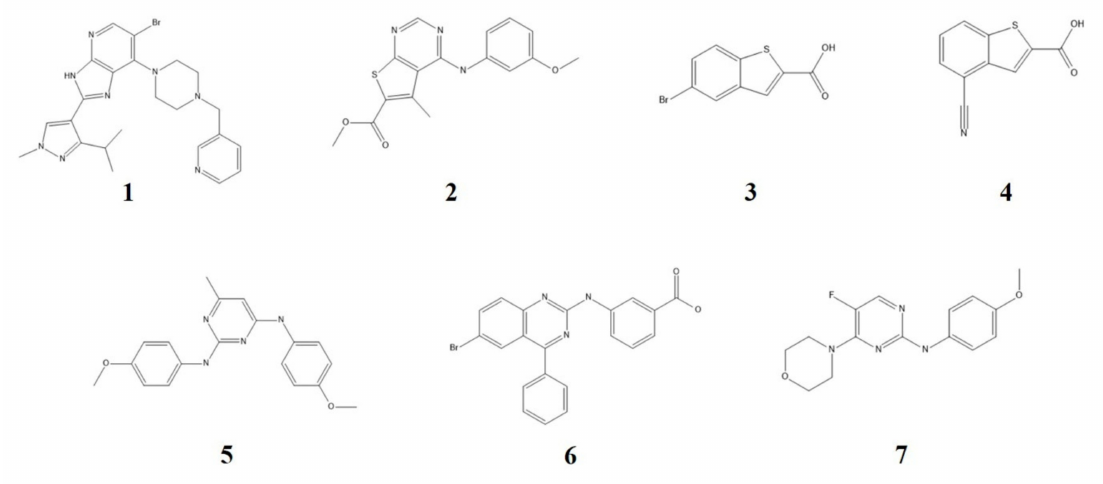
Figure 3. Structures of the selected compounds obtained from the in-house library